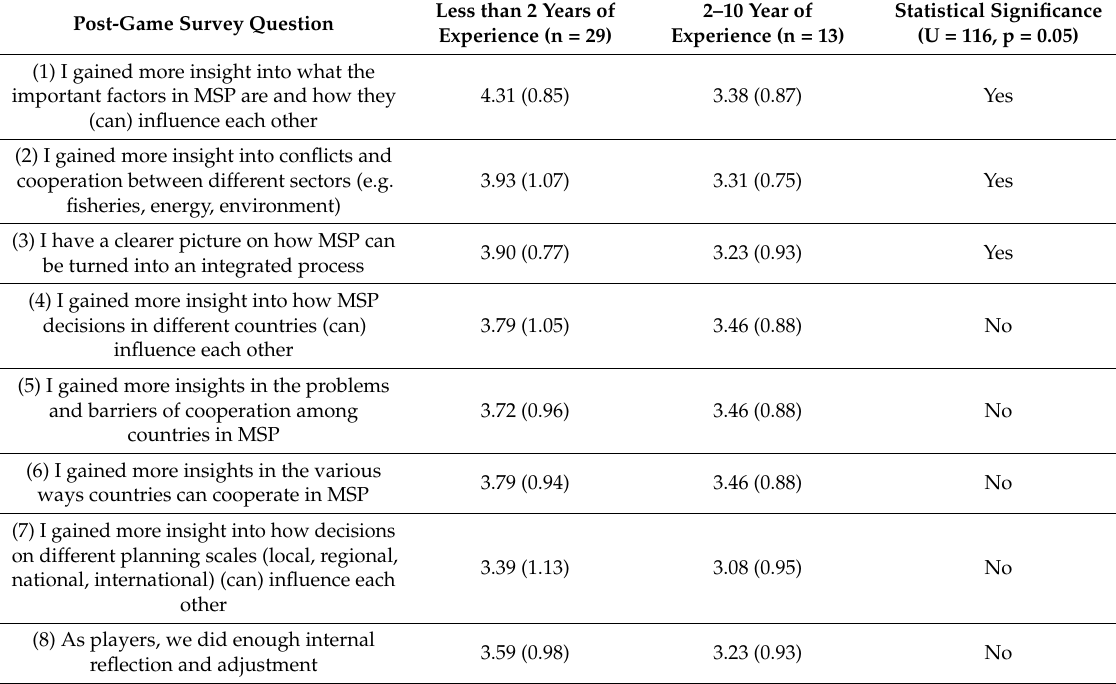
Table 3. Average question score with standard deviation in parenthesis for post-game survey questions that look at learning